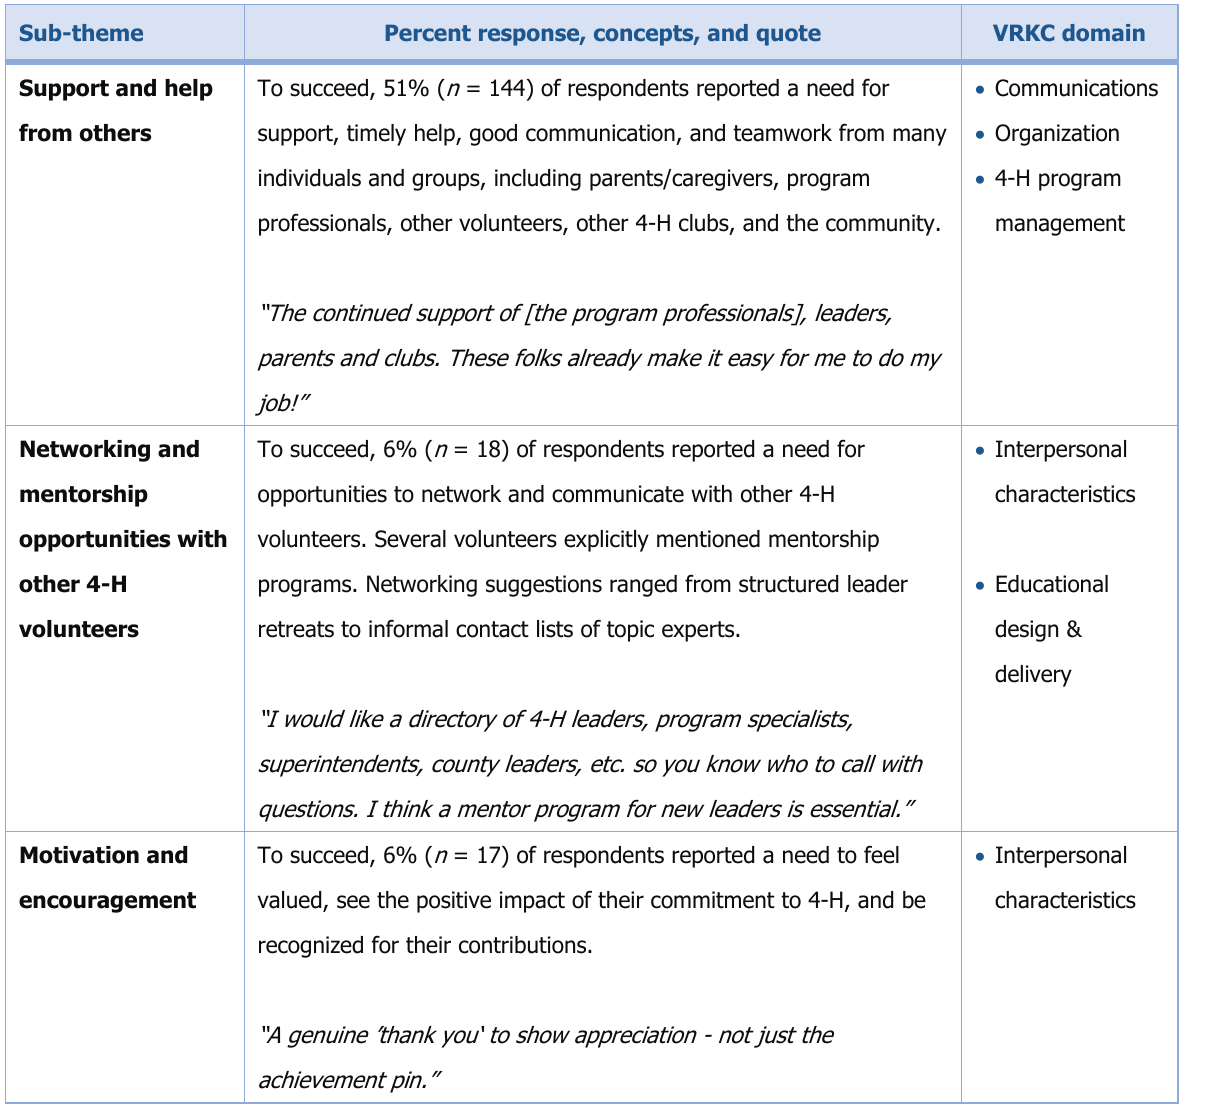
Table 7. “Needs for Success” Sub -Themes of the Supportive Relationships Theme